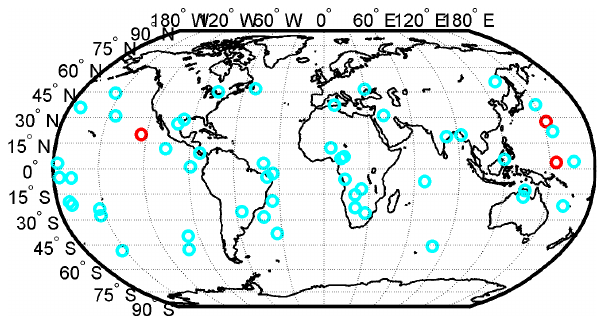
Fig. 1. Locations of the Convective Clusters co-located with GPS radio occultations described in Table 1. In red the cases detailed in paragraph